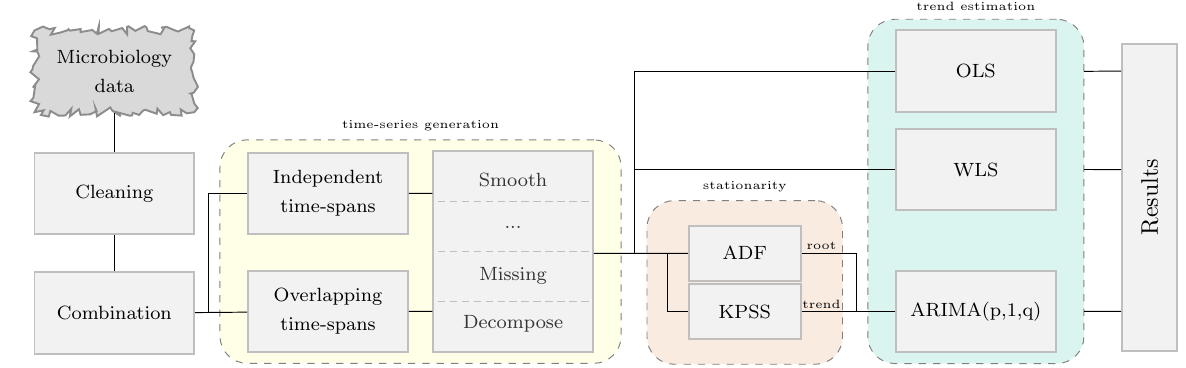
Figure 1. High-level methodology diagram. It is composed by three main sections: time series generation (yellow), stationarity analysis (orange) and trend estimation (green). The stationarity analysis was performed using the Augmented Dickey-Fuller (ADF) and the Kwiatkowski–Phillips–Schmidt–Shin (KPSS) tests to identify root-stationary and trend- stationary time series signals. The regression analysis methods considered were ordinary least squares (OLS), weighted least squares (WLS) and autoregressive integrated moving average